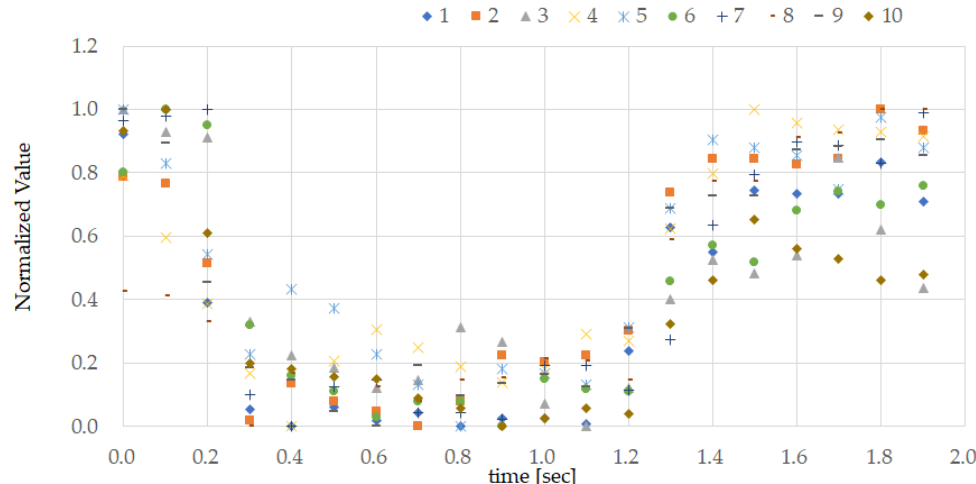
Figure 7. Measured values of person A while walking. The result is obtained by normalizing the measurement values of the earphone-type sensor when person A performs the TEMPO 10 times while walking. These measurement values were obtained from the experiment discussed in Section 3.3. Table 1. Results of the PAP operation experiment: Subjects A–E were tested while resting for 3 min, masticating 100 times, and walking for 80 s. A TEMPO was performed ten times in synchronization with the lighting of a timing-teaching LED as described in Section 3.3. The accuracy, precision, and recall were calculated from the obtained data. Accuracy